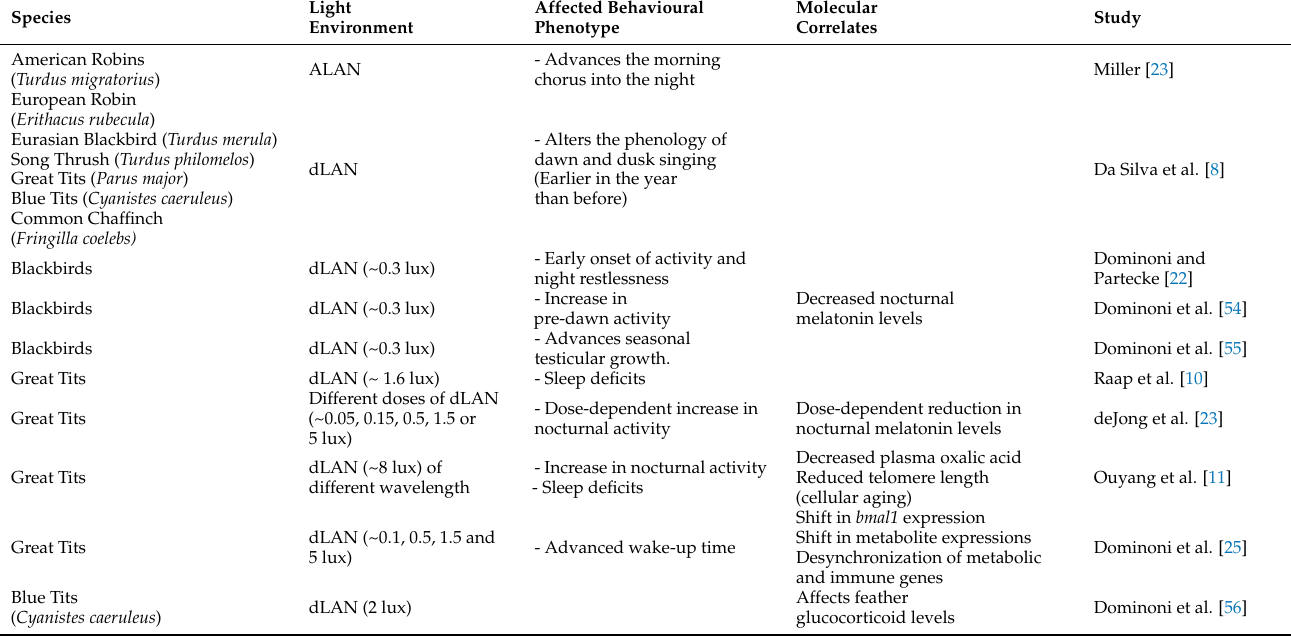
Table 1. Summary of the results from recent studies in different avian species highlighting the effects of light at night on behavioural phenotypes and the molecular